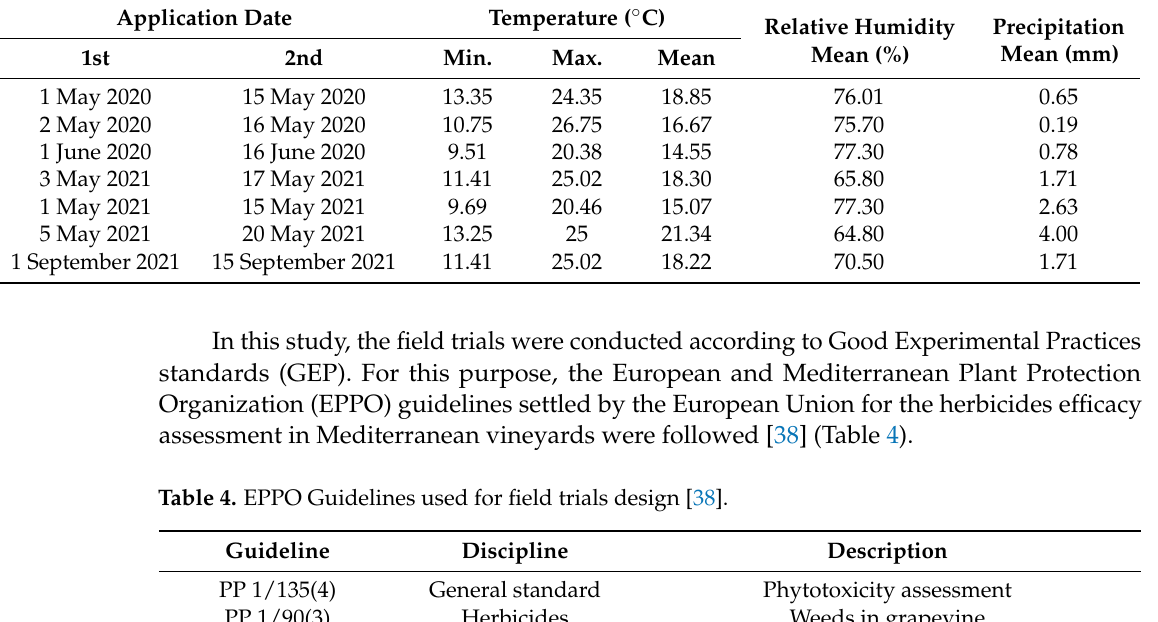
Table 4. EPPO Guidelines used for field trials design [38].